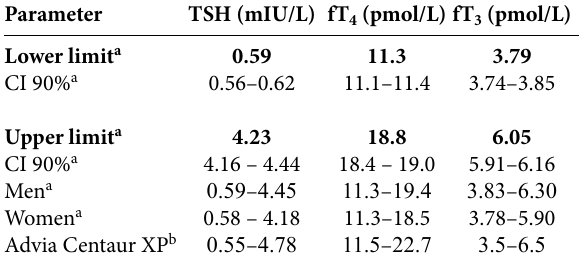
Table 1. Reference intervals for serum concentration of TSH, fT 4 and fT 3 obtained from 1722 reference individuals, given also sepa- rately for men (398) and women (1324). Comparison of laborato- ry-own and manufacturer’s reference intervals.